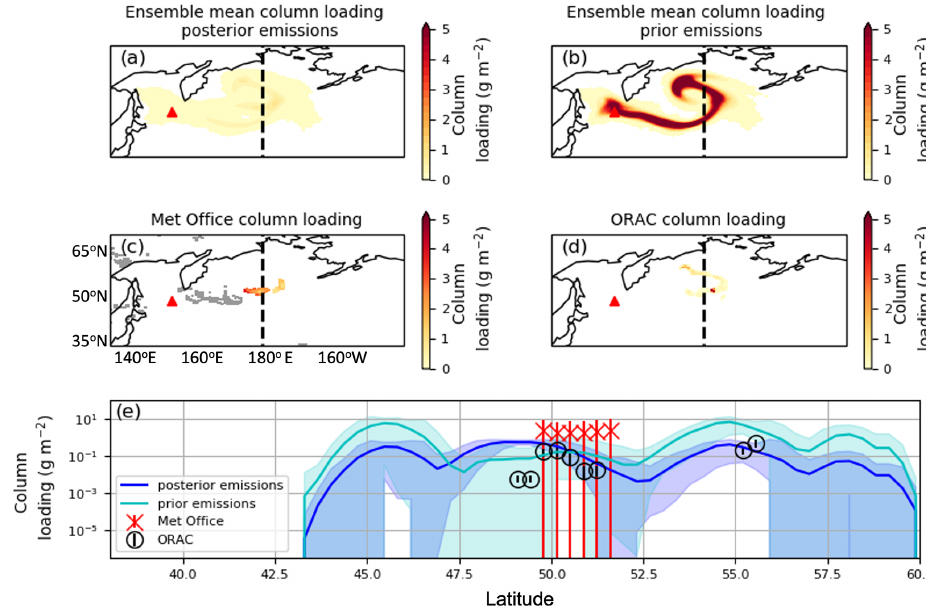
Figure 7. As Fig. 6 for 12:00UTC on 23 June